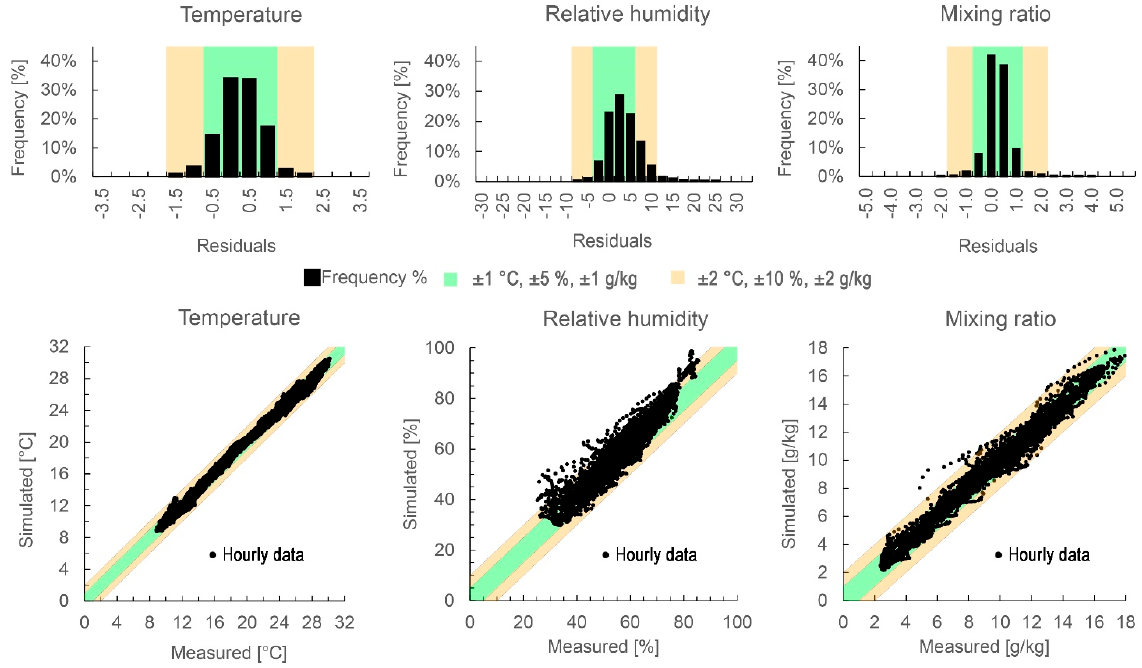
Figure 8. Comparative graphs between measured and simulated temperature data.